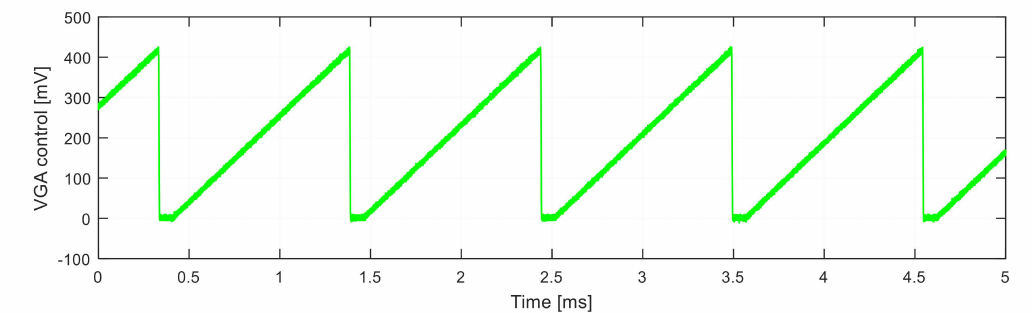
Figure 15. VGA control voltage.